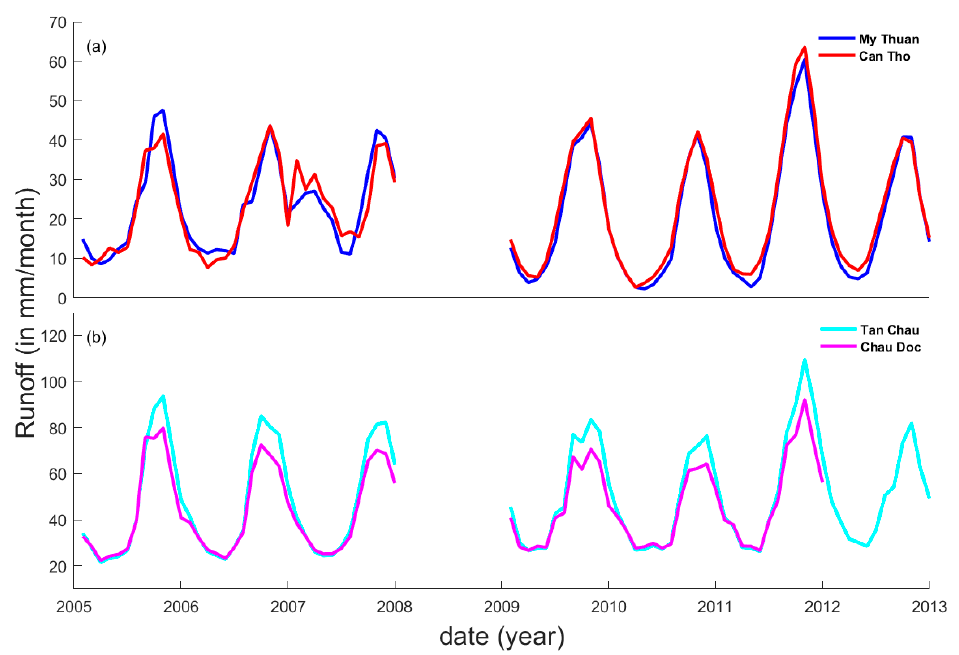
Figure 3. Runoff time series at ( a ) My Thuan and Can Tho stations, and ( b ) Tan Chau and Chau Doc stations.